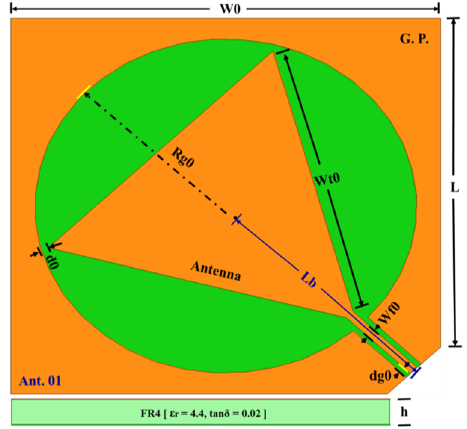
Figure 1. Configuration of the constructed Slot antenna 1.